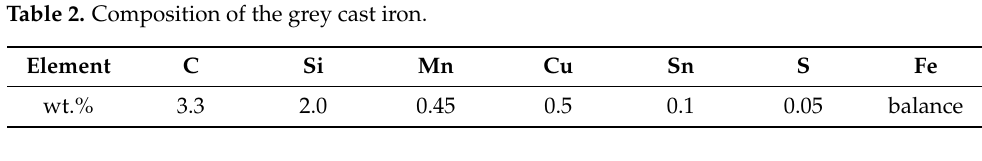
Table 3. Parameters of plasma cladding.